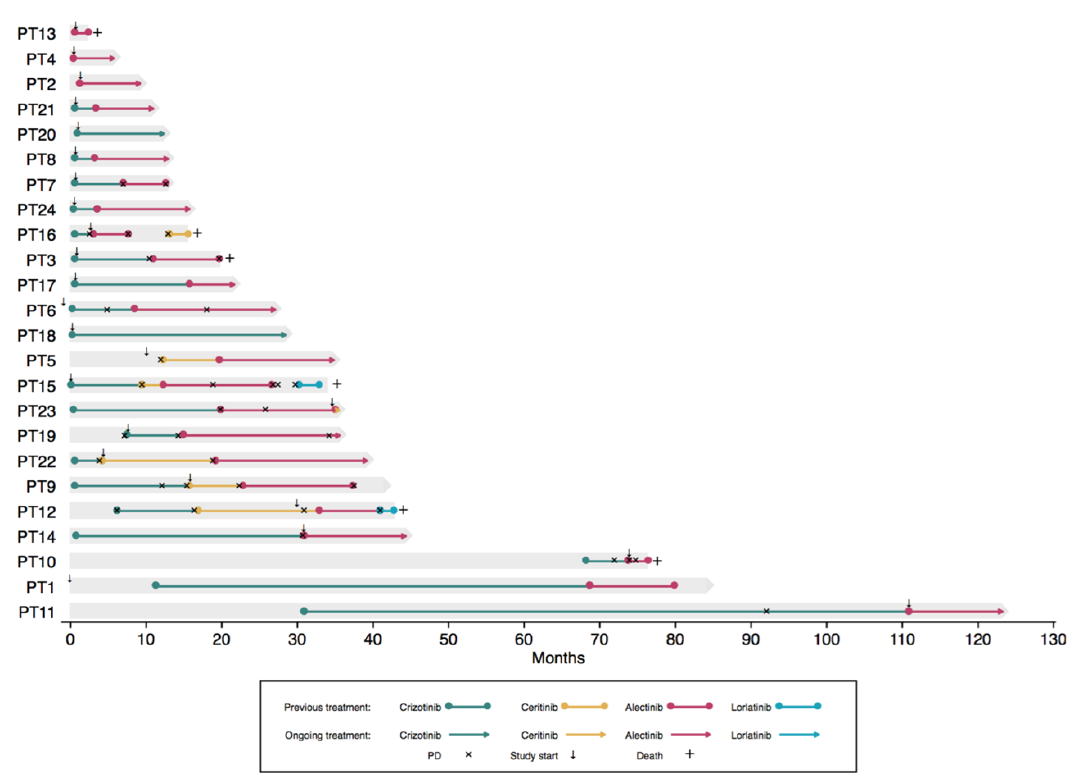
Figure 1. Individual treatment trajectories. The x -axis depicts months since diagnosis, and the y -axis depicts each patient. Deceased patients are marked by + , and progression is marked by × . The small arrows mark when the patient was included in the present study. PD, progressive disease.